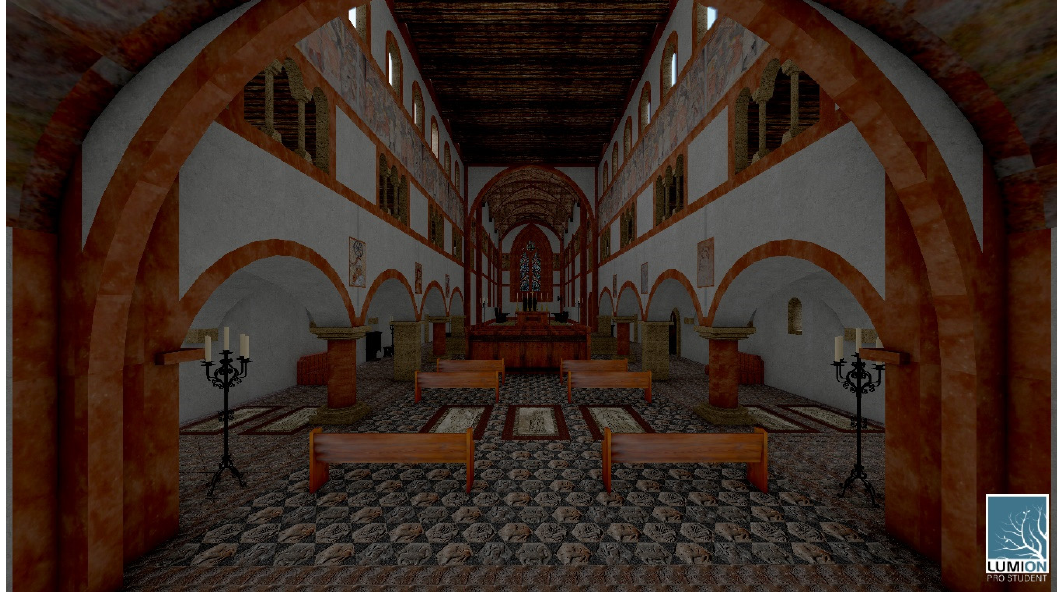
Figure 13. Gothic basilica interiors including paintings of the period and tombs. Own work (2020).